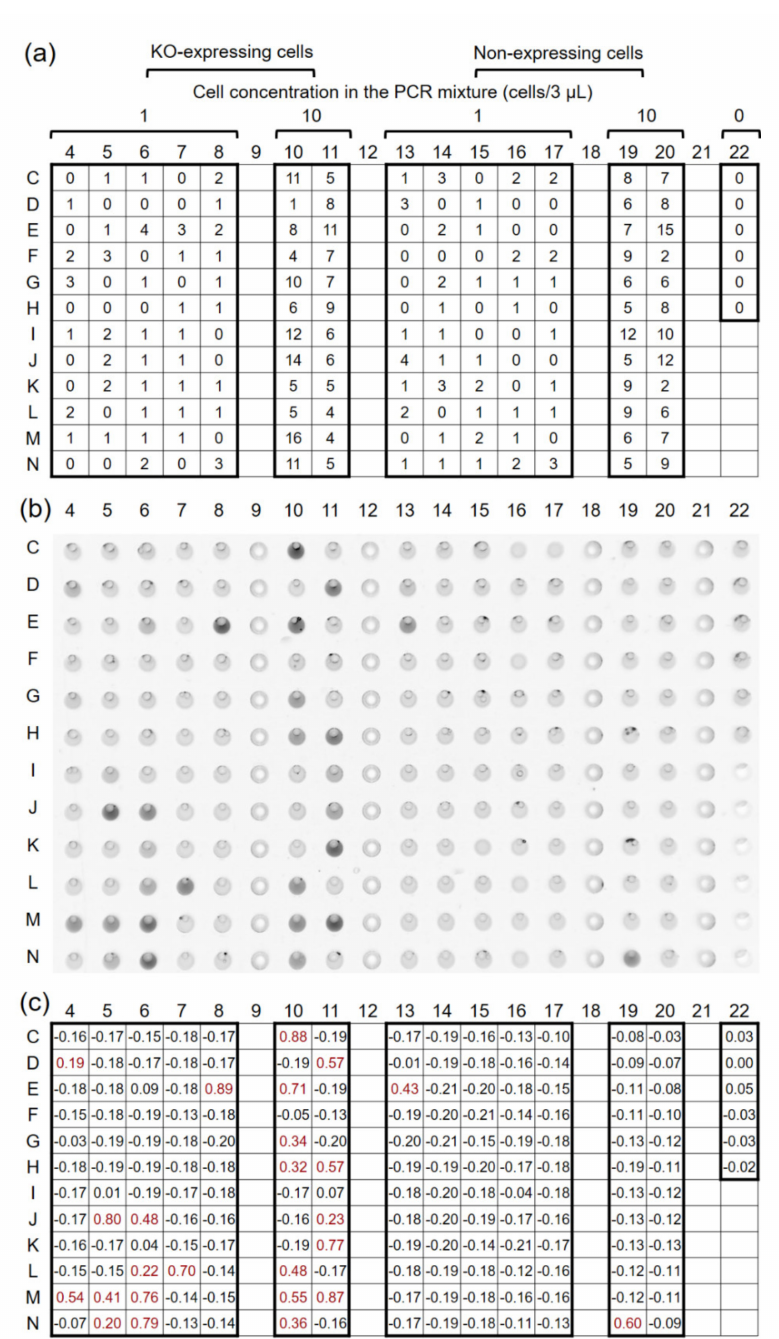
Figure 7. Cell numbers and PCR results for each well. ( a ) Cell numbers and plate layout. ( b ) Plate image of 6-carboxyfluorescein (FAM) fluorescence obtained by an image scanner. ( c ) The values in each well represent ∆ Rn. Red text indicates the PCR-positive well ( ∆ Rn >